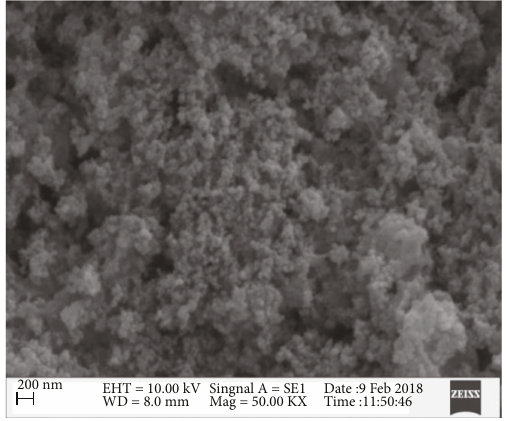
Figure 2: SEM micrograph shows the surface morphology of a fi nanoporous TiO 2